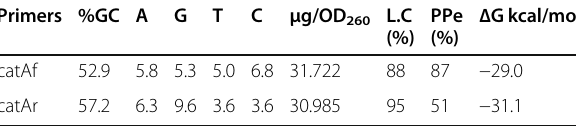
Table 3 Degenerate PCR primer